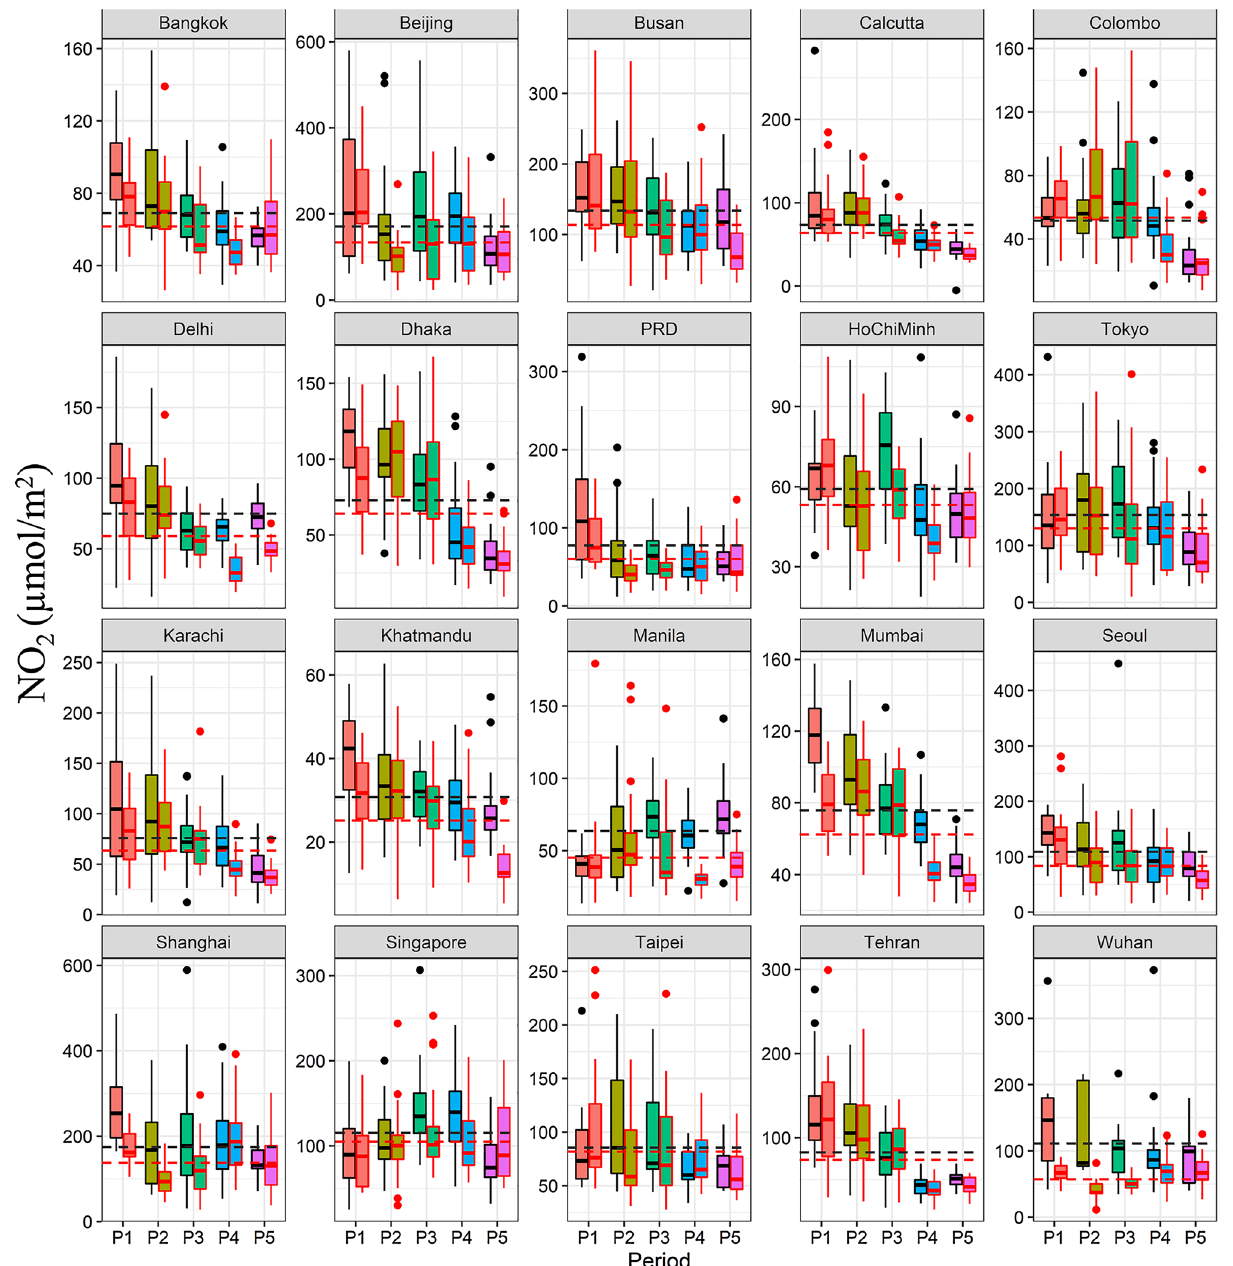
Figure 3. Periodic changes of NO 2 concentration of the cities in 2019 and 2020 during the P1 (Jan 1–Jan 22), P2 (Jan 23–Feb 22), P3 (Feb 23–Mar 22), P4 (Mar 23–Apr 22) and P5 (Apr 23–May 22). The black and red dotted lines indicate mean NO 2 concentration (Jan 1–May 22) in 2019 and 2020 and the dots indicate outliers,